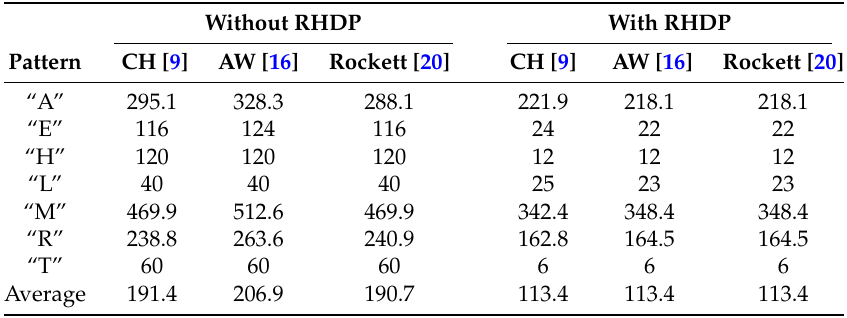
Table 3. MSD measurements for the results given in Figure 14 by applying the presented approach with three fully-parallel thinning algorithms. The average MSD with the RHDP process is 42% less than that without the RHDP